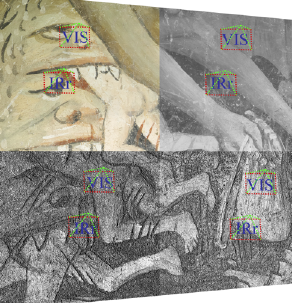
Figure 11: Example of multilayered output (VIS/IR) orthophoto and related shaded maps on Leviathan case-study in La